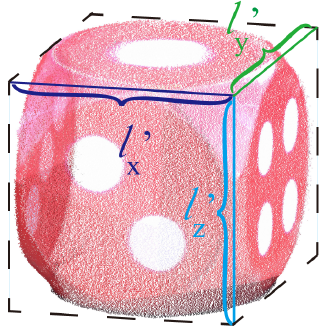
Figure 10. Dimensions of the die for the proposed calibration procedure.